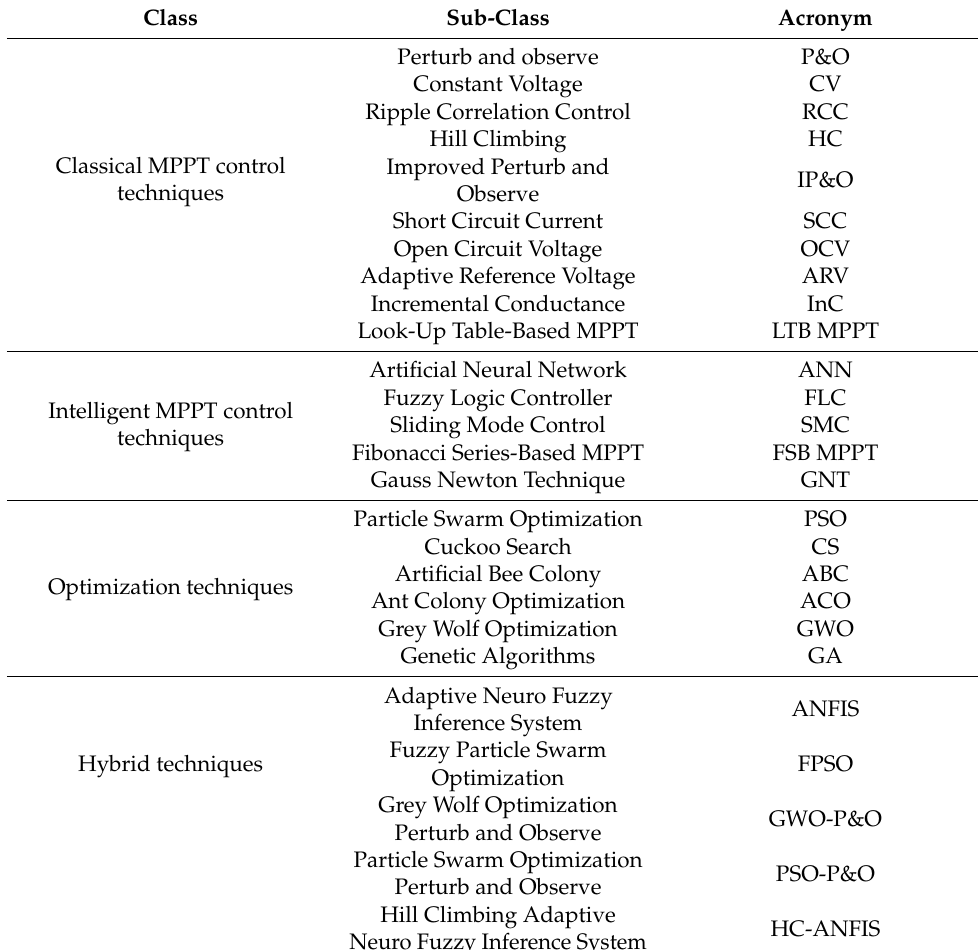
Table 1. Classification of MPPT techniques (redrawn with data from